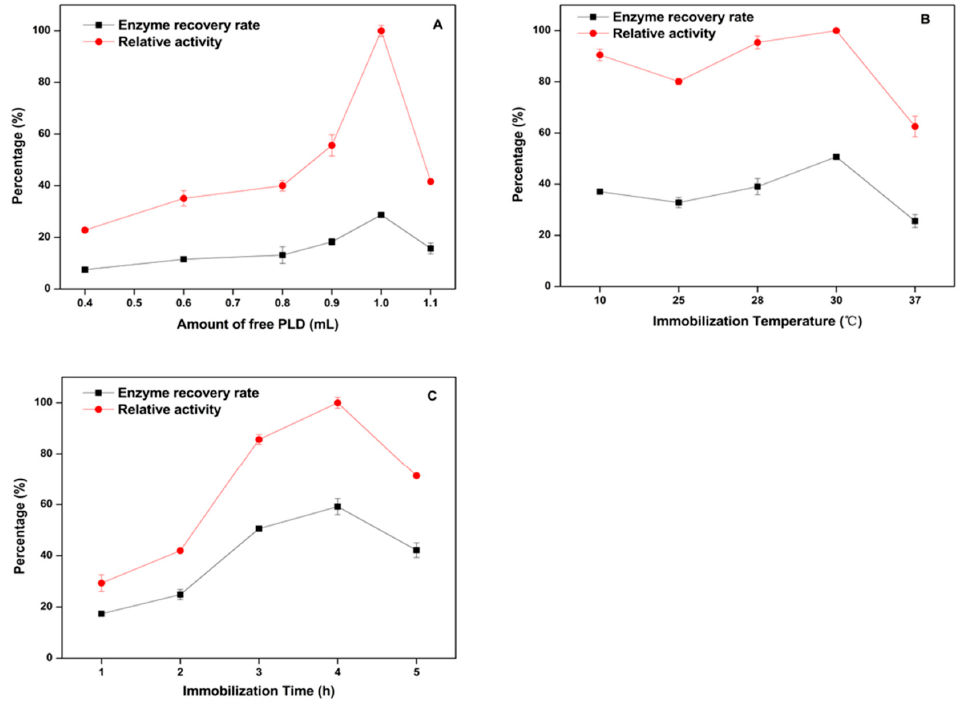
Figure 4. The effect of the initial PLD a2 volume(A), temperature (B), and reaction time(C) on the enzyme recovery rate and the relative activity.